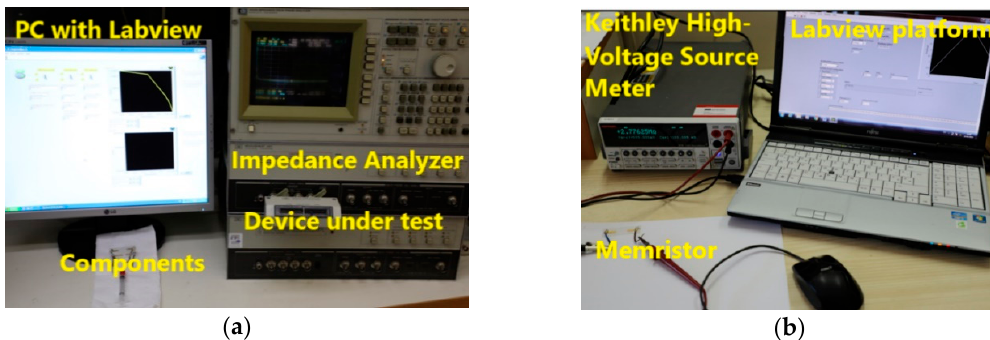
Figure 9. Experimental set-up with: ( a ) Impedance Analyzer HP4194A for experimental testing of microfluidic resistor, inductor, and capacitor, ( b ) Keithley 2410 for experimental determination of microfluidic memristor characteristics.